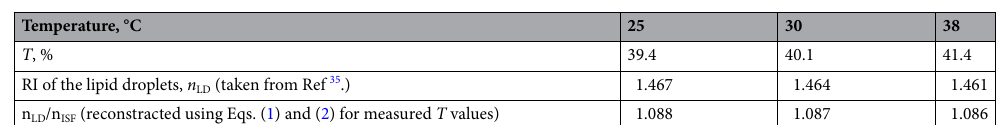
Table 2. The transmittance T (%) of the laser beam (632.8 nm) through a rat AT layer of thickness 120 ± 15 μm) (in vivo study) with tissue heating (see Fig. 8).